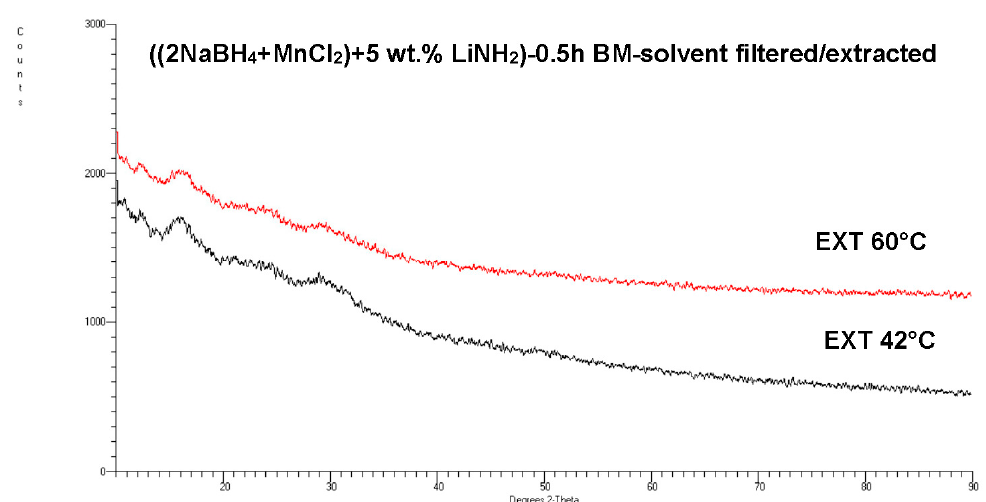
Figure 11. XRD pattern for the ((2NaBH 4 + MnCl 2 ) + 5 wt. % LiNH 2 ) sample, ball milled for 0.5 h (Q TR = 36.4 kJ/g) and subsequently filtered/extracted (EXT) at 42 °C and 60 °C using an evaporation time of 6–7 min.